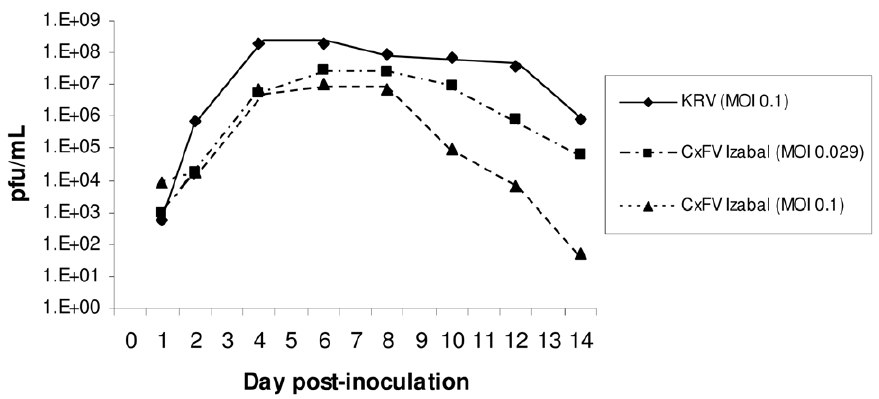
Figure 2. Replication of CxFV Izabal and KRV in C6/36 cells.